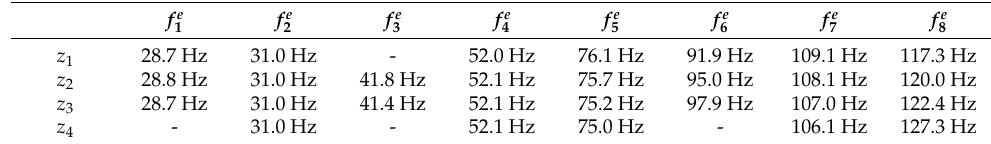
for the WPT position z 2 with the lowest number of Table 10. Identified first eight eigenfrequencies f e i found modes and the equivalent modes’ eigenfrequencies at the other positions; “-” indicates that no matching mode with a MAC value of at least 80% was found.